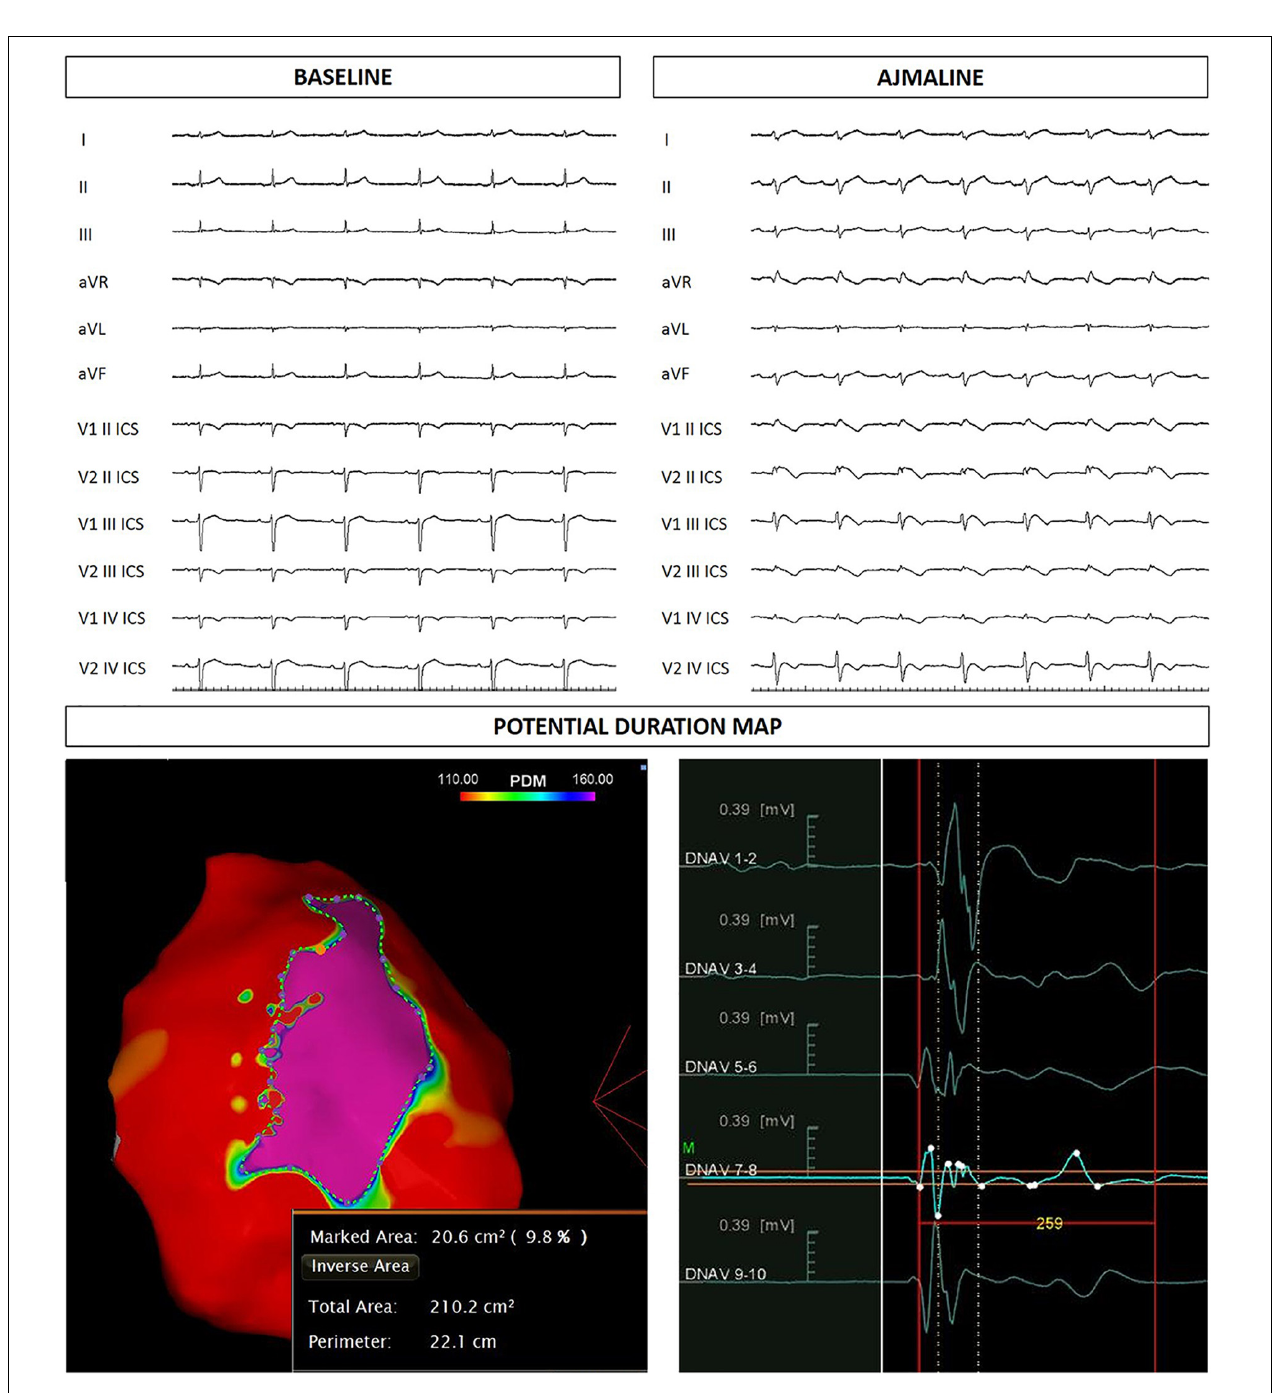
FIGURE 4 | Sister of the proband: ECG at baseline and after ajmaline administration. Epicardial arrhythmogenic